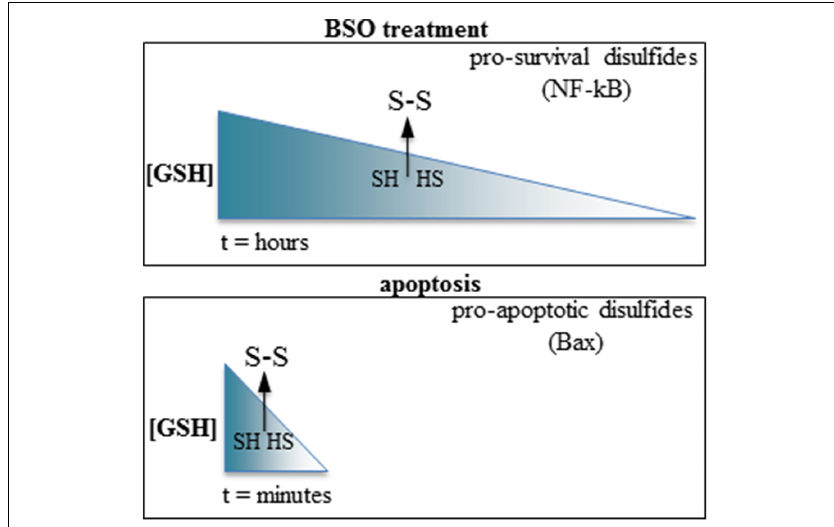
FIGURE 1 | Slow vs. fast GSH depletion produce opposite effects on cell survival. Top: BSO induce slow GSH depletion (hours); the disulfides formed after reaching a threshold level of redox imbalance possess a cell-survival activity (e.g., the p50 subunit of NF-kappaB). Bottom: the very rapid GSH extrusion occurring in apoptosis promote the formation of pro-apoptotic disulfides (e.g., Bax). The arrows indicate a hypothetical threshold level of GSH depletion after which sulfhydryls (SH, HS) are oxidized to disulfides (S-S) in each